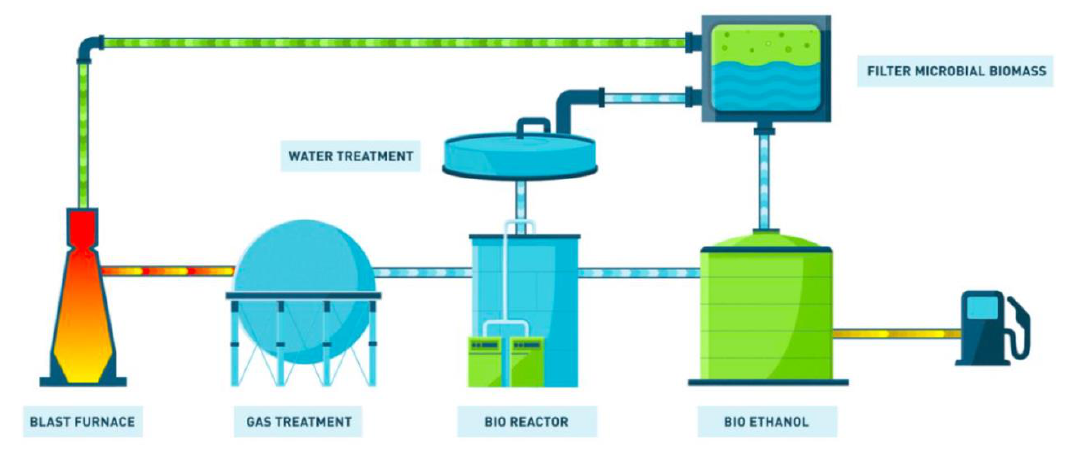
Figure 32. The STEELANOL project (source: ArcelorMittal).